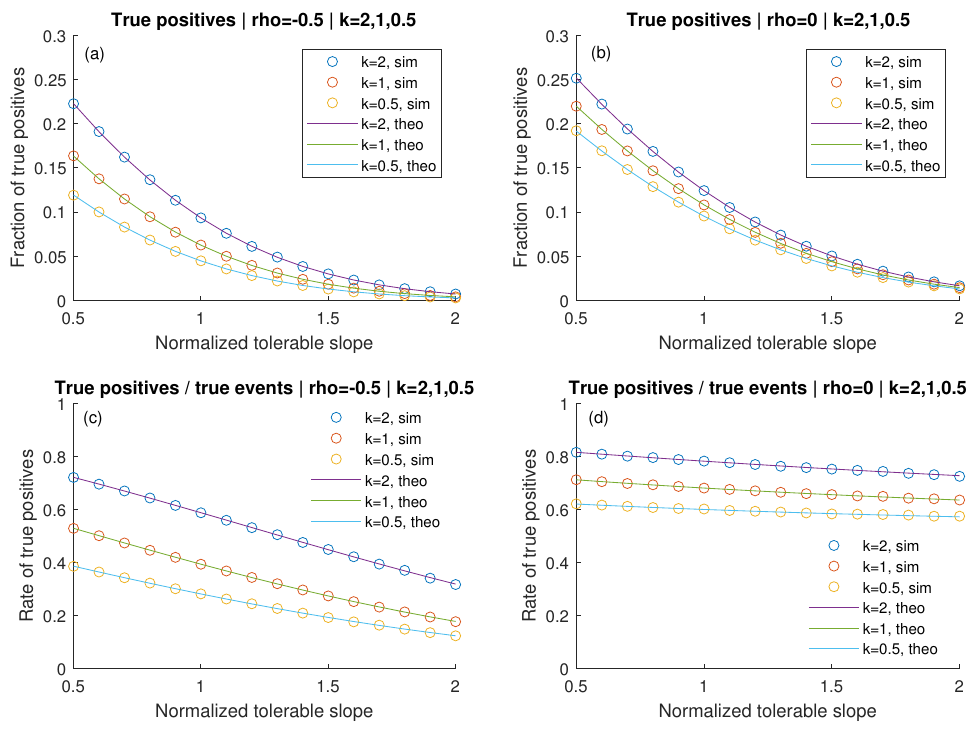
Figure 4. Fraction of true positives observed ( a , b ) and the respective detection efficiencies ( c , d ), for different combinations of the correlation coefficient ρ and the standard deviation ratio κ . Left col- umn ( a , c ): Negative correlation coefficient. Right column ( b , d ): Zero correlation. Circles: Numerical simulation. Solid lines: Theory.